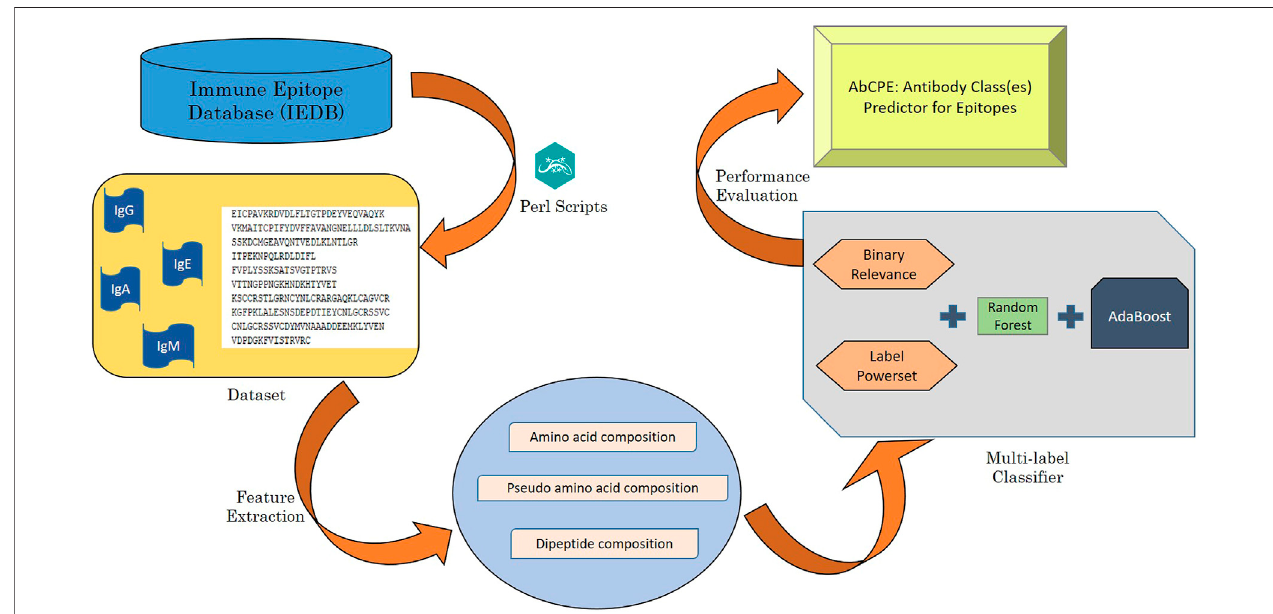
FIGURE 1 | Diagrammatic illustration of AbCPE